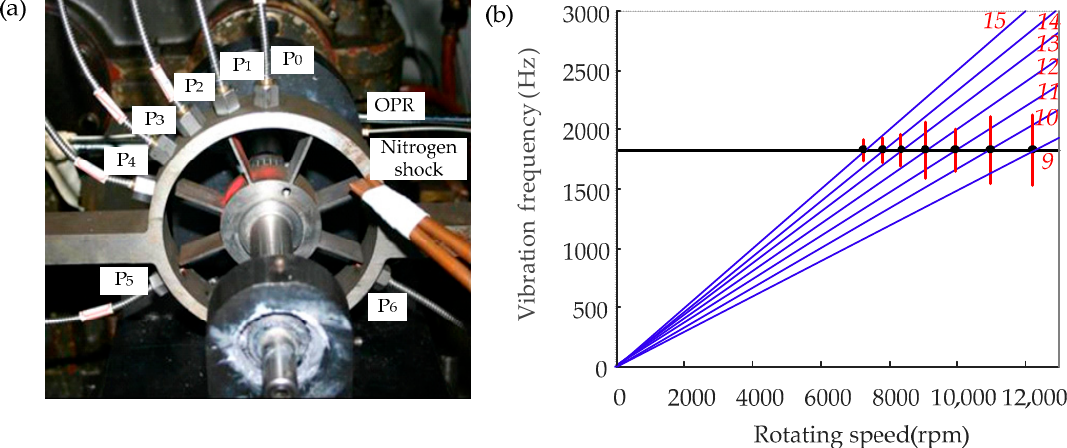
Figure 11. ( a ) The test rig and ( b ) the blade Campbell diagram.